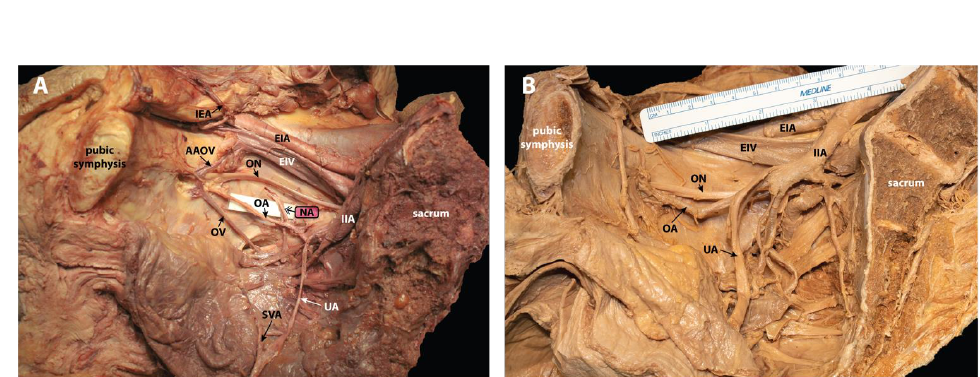
Figure 1. Pelvic hemisection of an unconventional nutrient artery (NA) and a typical vascular pat- tern in phenol-fixed human donors. Donor bodies were dissected as part of the gross anatomy